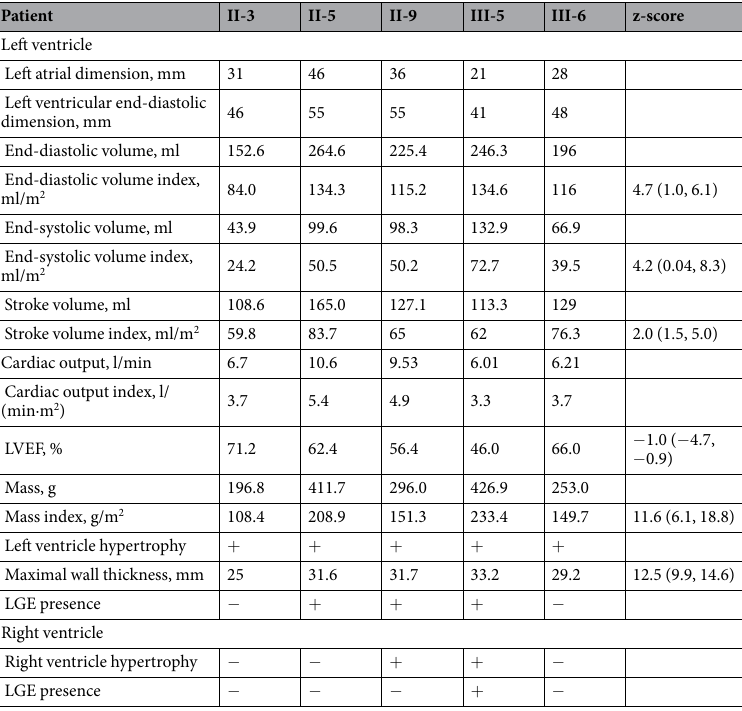
− − − + − Table 2. CMR characteristics of five patients with PRKAG2 mutation in the current family. LVEF, left ventricular ejection fraction; LGE, late gadolinium